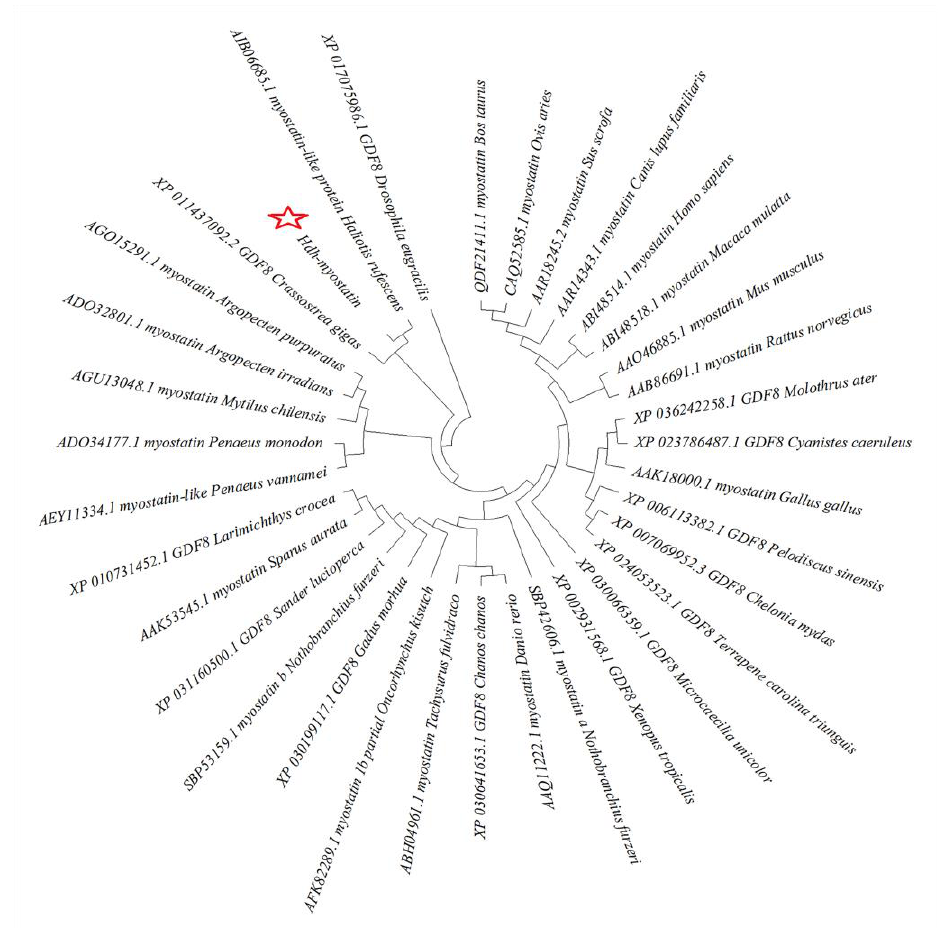
Figure 2. Amino acid secondary structure of hdh- myostatin. Hh expresses the α -helix. Ee expresses the extended strand. Tt expresses the β -turn. Cc expresses the random coil.